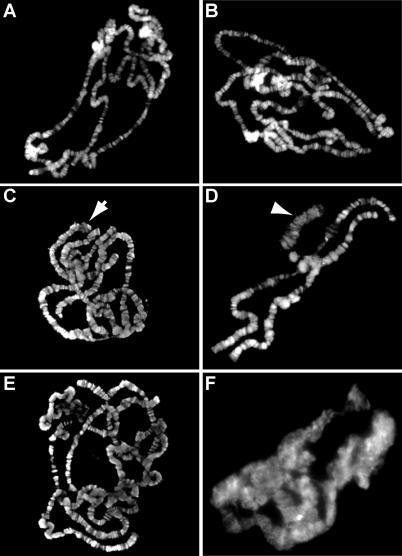
ISWI Plays a Global Role in Chromosome Compaction In VivoPolytene chromosomes were prepared from larval salivary glands and stained with DAPI. Wild-type female (A) and male (B) polytene chromosomes exhibit normal morphology. The loss of zygotic Iswi function in Iswi1/Iswi2 larvae causes the decondensation of the X chromosome in male (D, arrowhead) but not female (C, arrow) larvae. Expression of wild-type ISWI does not dramatically alter chromosome morphology (E). By contrast, the expression of a dominant-negative ISWI protein (ISWIK159R) in salivary gland nuclei causes the dramatic decondensation of all chromosomes (F).